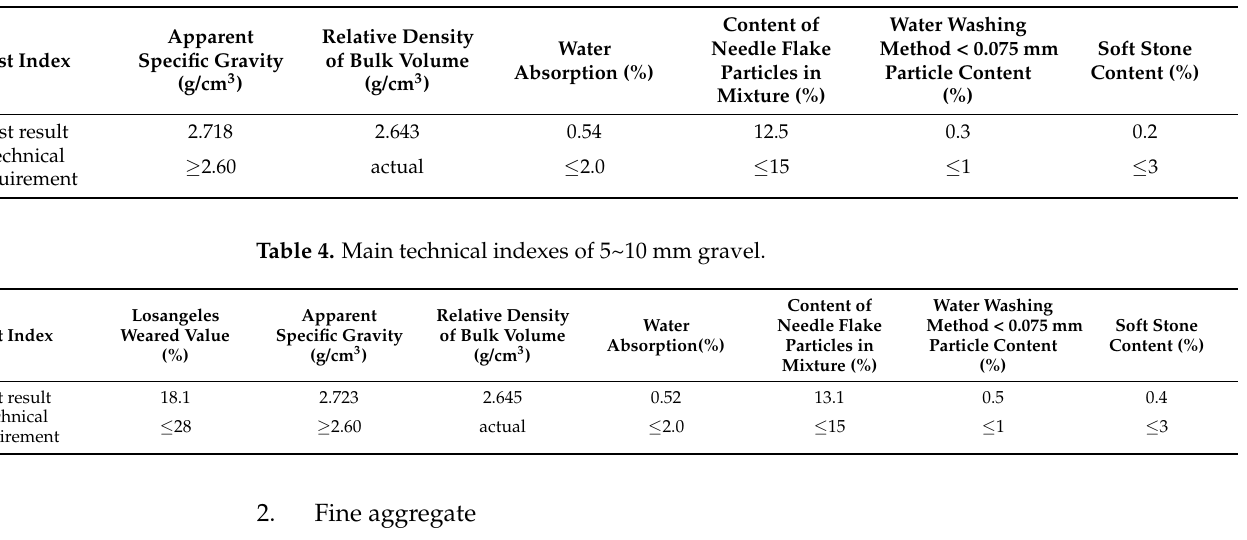
Table 3. Main technical indexes of 3~5 mm gravel.